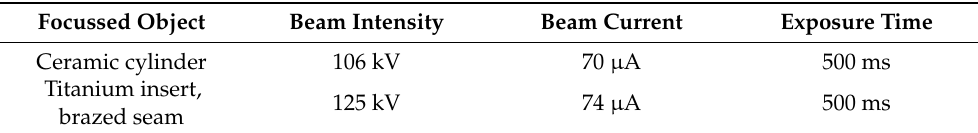
Table 3. CT scan parameter.